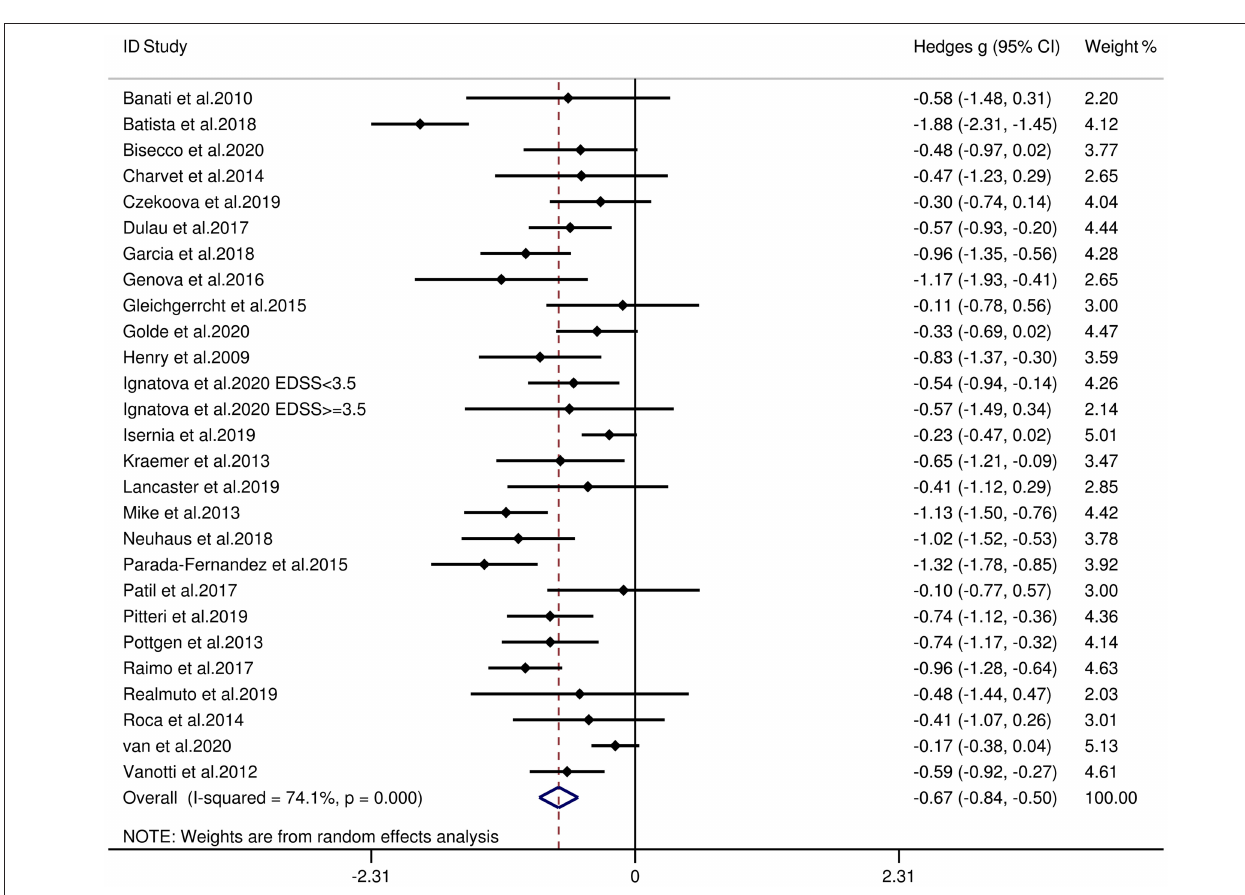
TABLE 3 | Mean effects for ToM and empathy subcomponents comparing participants with multiple sclerosis against healthy controls and tests for publication bias. Subcomponent K N in MS N in HCs g 95% CI Test for Heterogeneity Assess risk of publication bias groups groups Lower Upper I 2 statistic,% Egger’s test overall empathy 27 1,275 1,110 − 0.67 − 0.84 22 CogEmp/AffTom 25 972 957 −